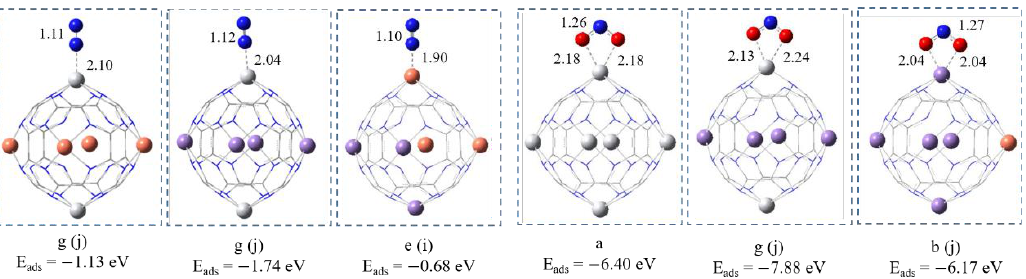
Figure 8. The optimized configurations of N 2 and N 2 O on bi-metal complexes. All bond distances are in Å. Color code: white, Ti; orange, Cu; purple, Mn; red, O; grey, C; blue, N.